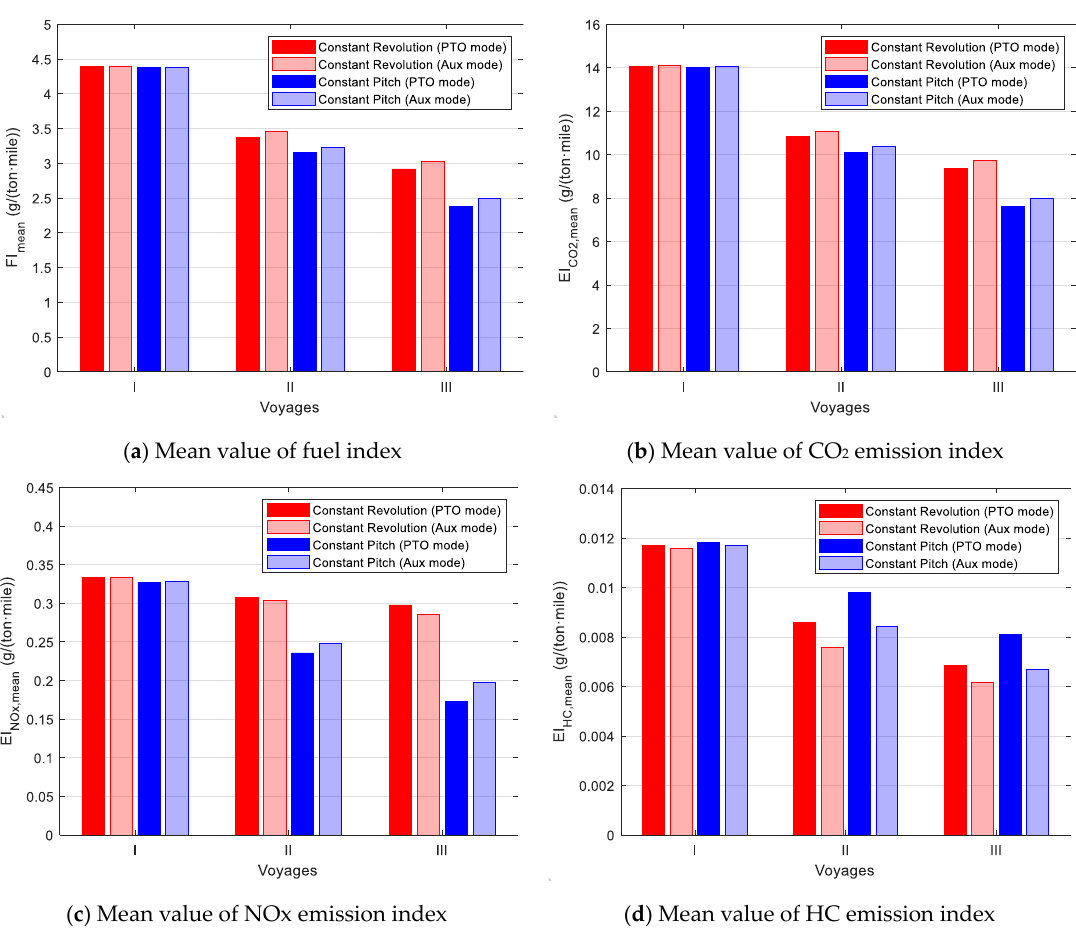
Figure 4. Mean value of fuel and emissions indices.